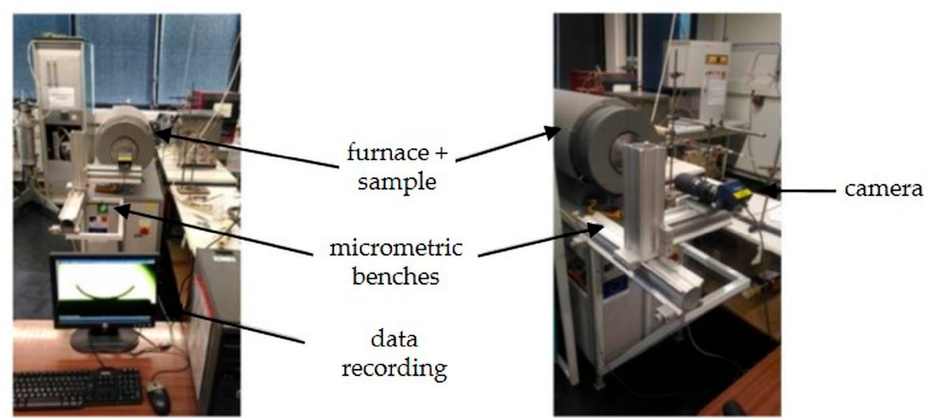
Figure 3. Developed device of ombroscopy.